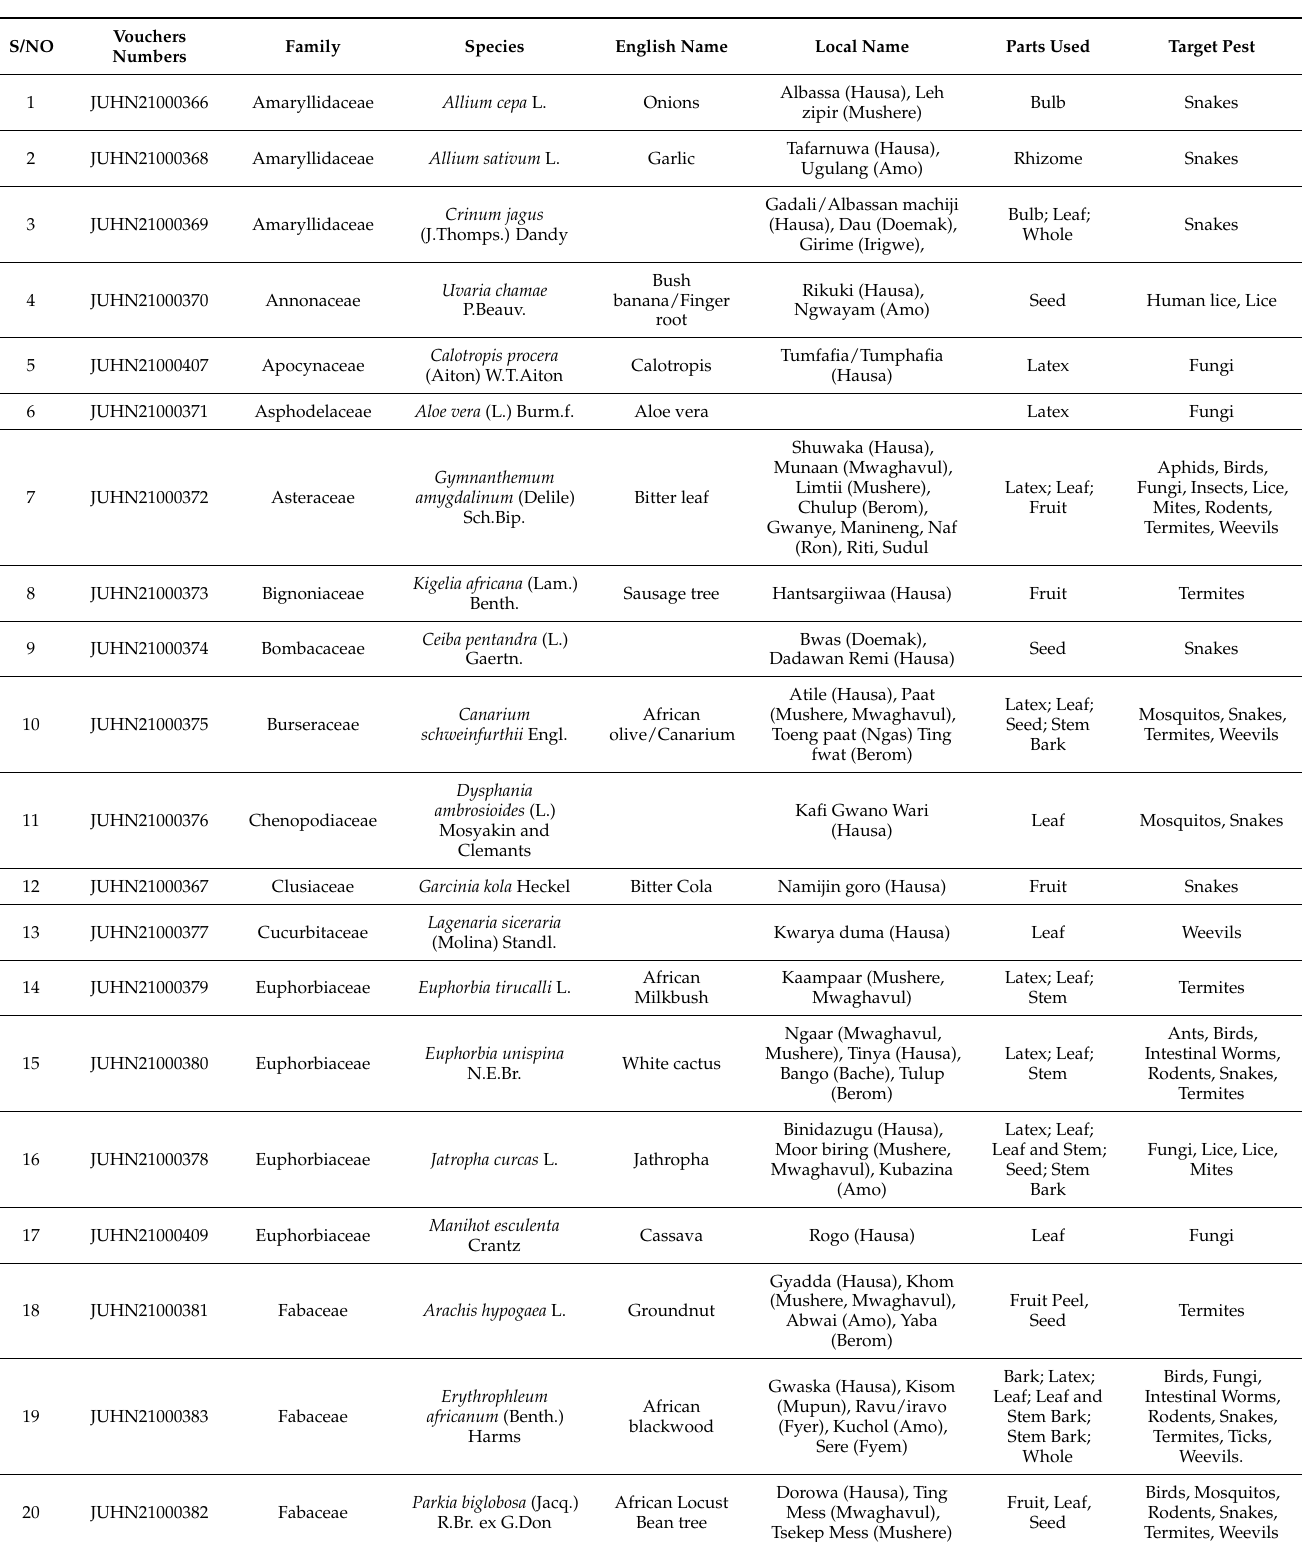
Table 2. Plants used as pesticides in Plateau State,